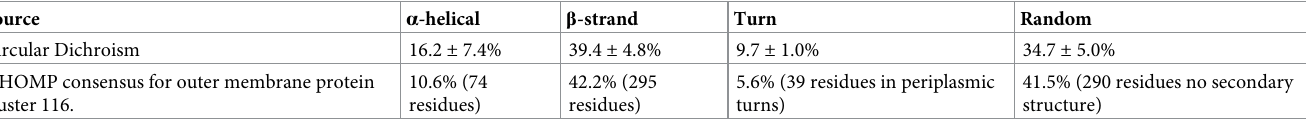
Table 1. Secondary structure of GfcD.